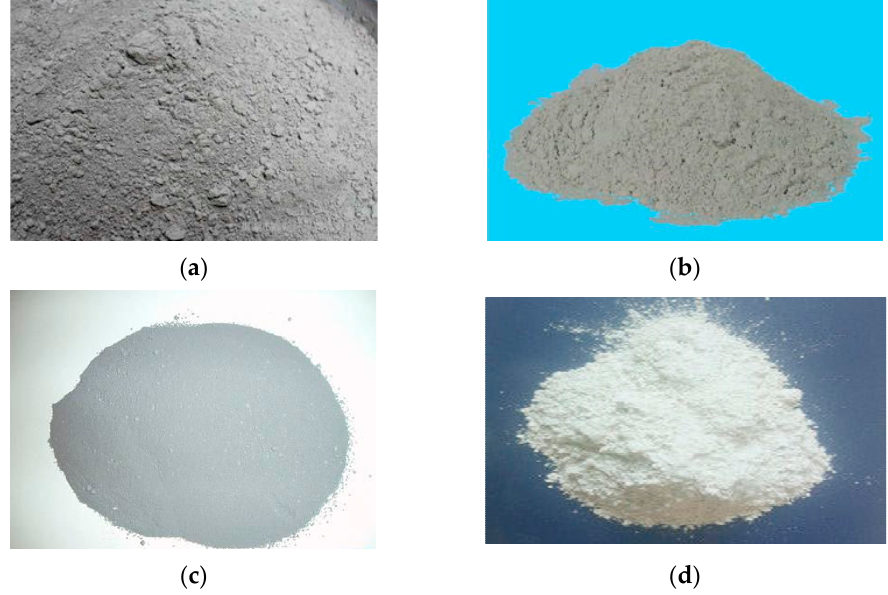
Figure 3. Raw materials: ( a ) fly Ash, ( b ) slag Powder, ( c ) silica Fume, and ( d ) stone Powder. Table 1. Main properties of cement and silica fume.